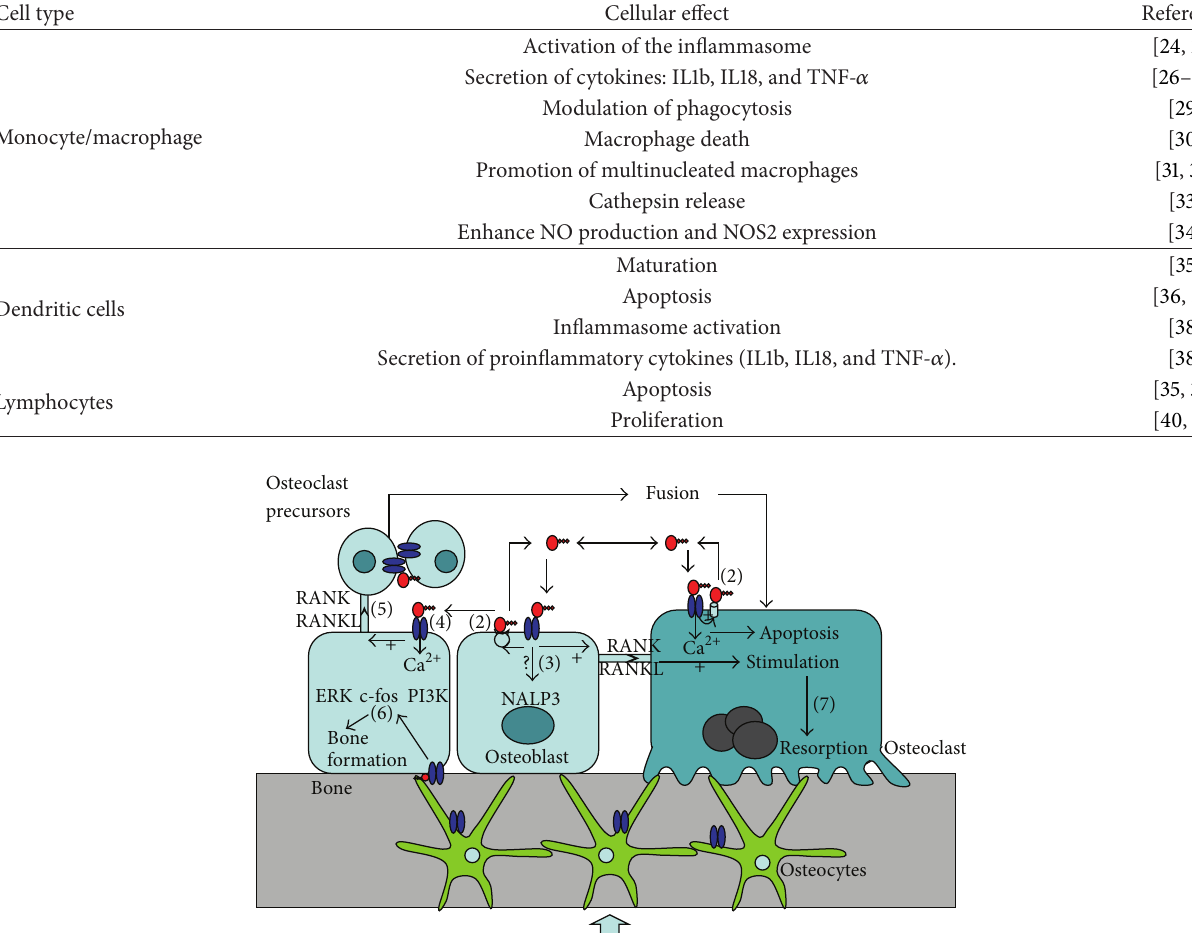
Table 1: Effects of P2X7 receptors in immune cells.